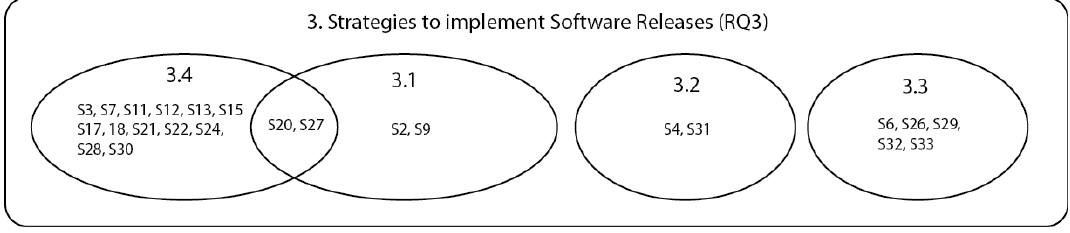
Figure 7. Types of strategies to implement software releases ( RQ3